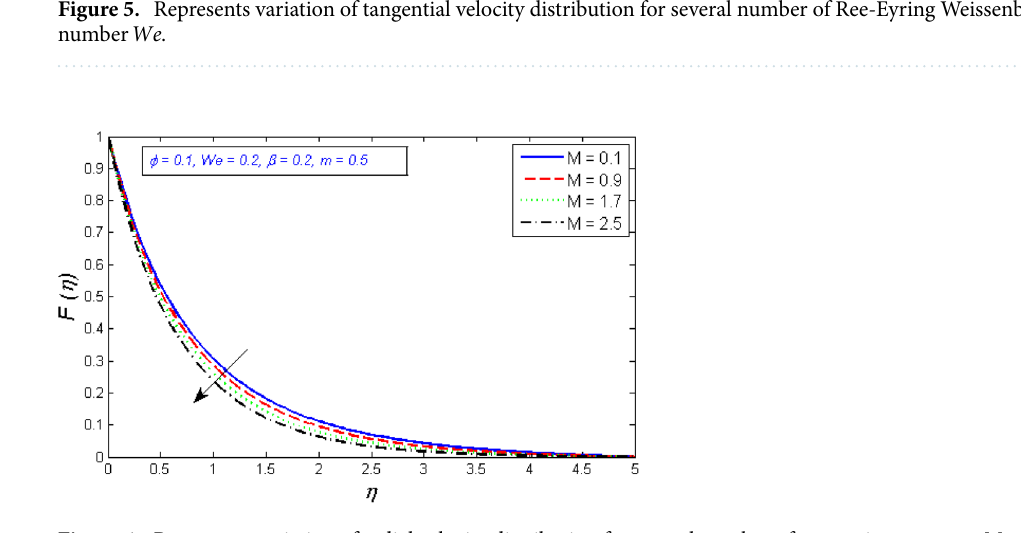
Figure 6. Represents variation of radial velocity distribution for several number of magnetic parameter M .